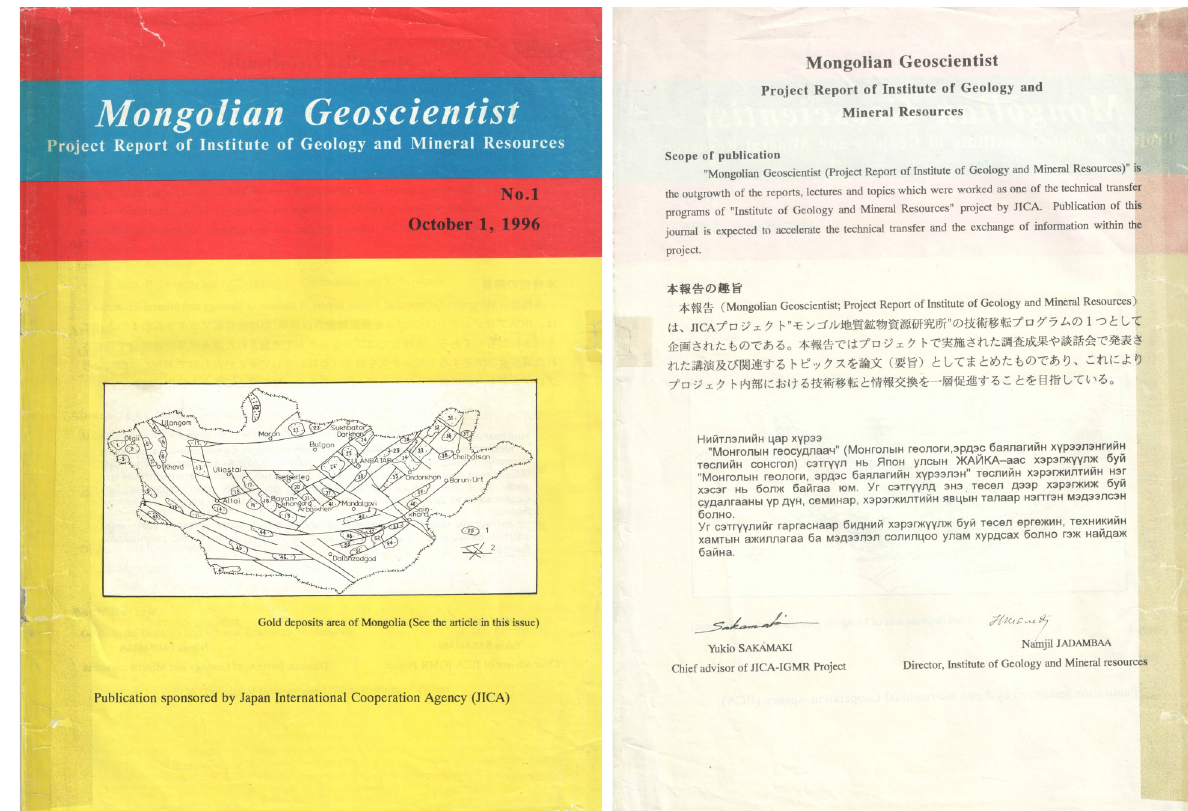
Fig. 1. The first issue of Mongolian Geoscientist, October